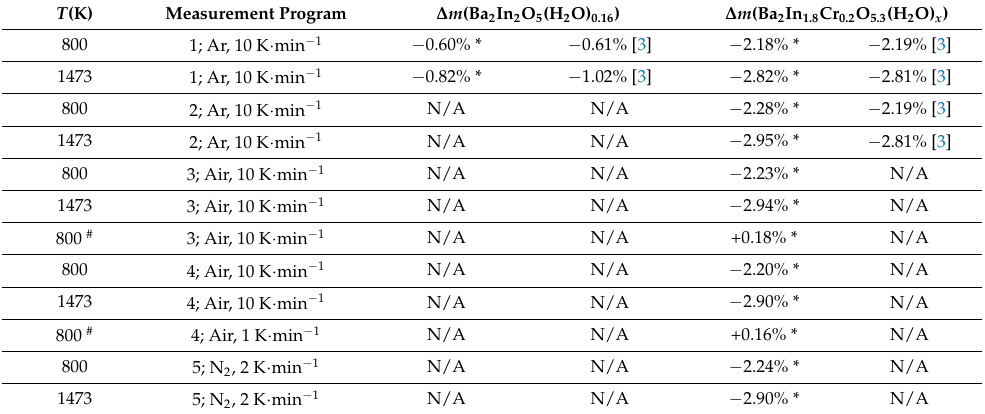
Table 2. Summary of the obtained weight changes during TGA measurements with different conditions.